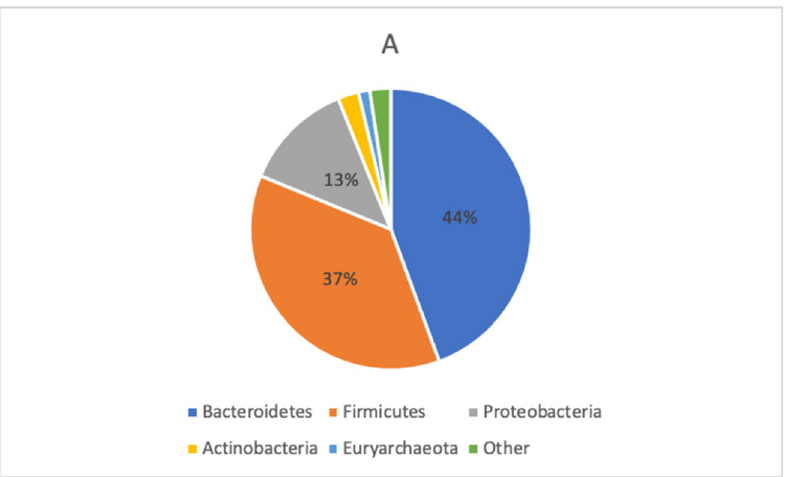
Fig 2. Taxonomic composition of bacterial phyla in FMS patients. In FMS, mostly dominant were Bacteroidetes (44%), followed by Firmicutes (37%) and Proteobacteria (13%). All phyla were tested for differences with DeSeq2 (GMPR normalization) which did not reveal any significant results. Abbreviations: gmpr–geometric mean of pairwise